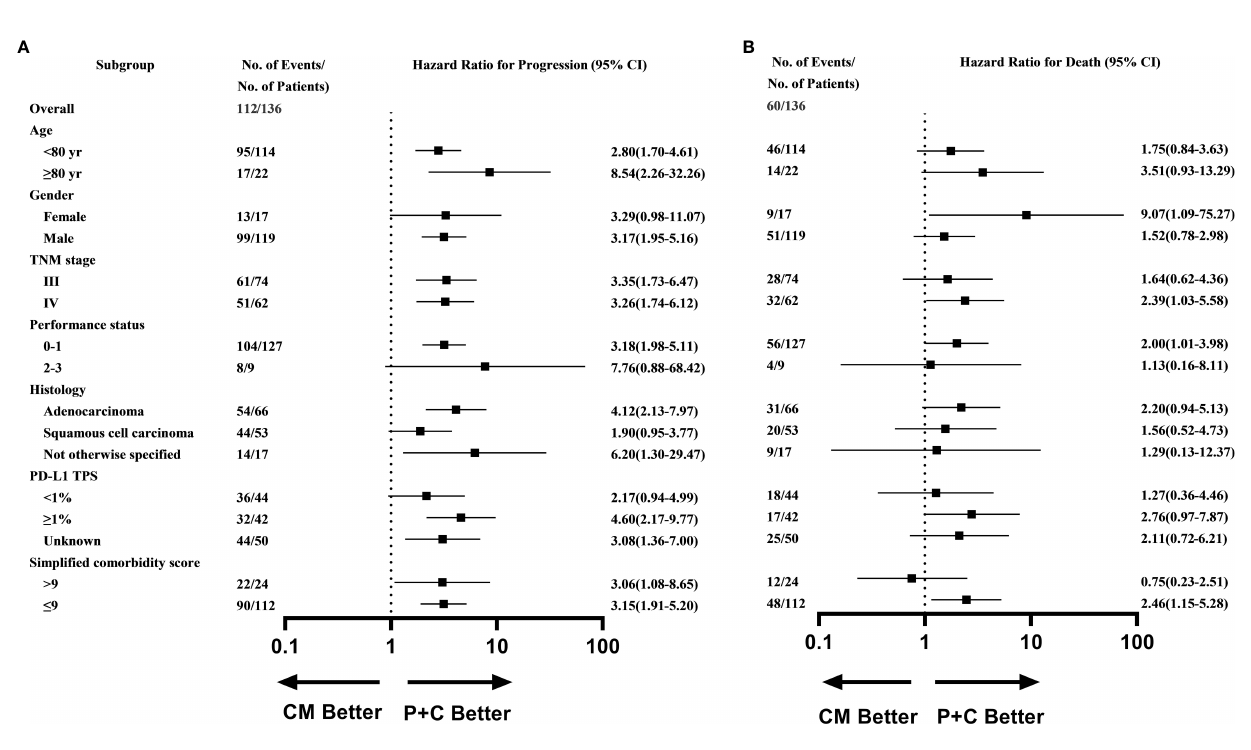
FIGURE 3 | Subgroup analysis of (A) Progression-free survival (B) Overall survival in P+C and CM